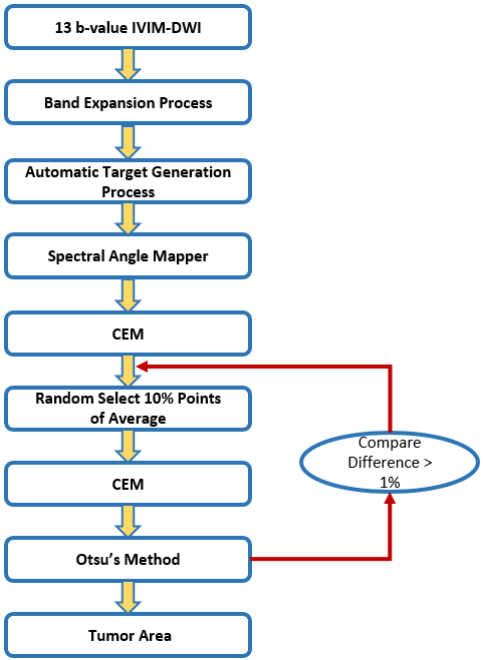
Figure 3. Flowchart of tumor detection via iterative-constrained energy maximization (I-CEM). Figure 4 is a flowchart depicting the steps involved in tumor detection via K-CEM.